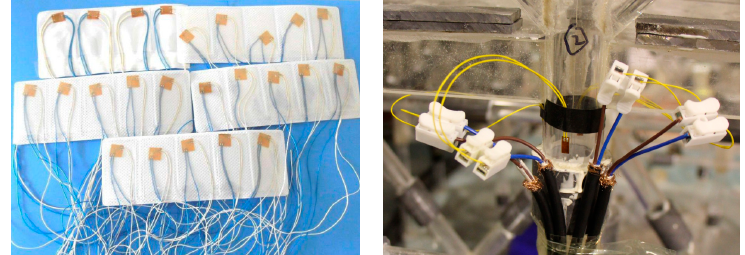
Figure 4. The experimental layout of the strain gauge. J. Mar. Sci. Eng. 2019 , 7 , x FOR PEER REVIEW